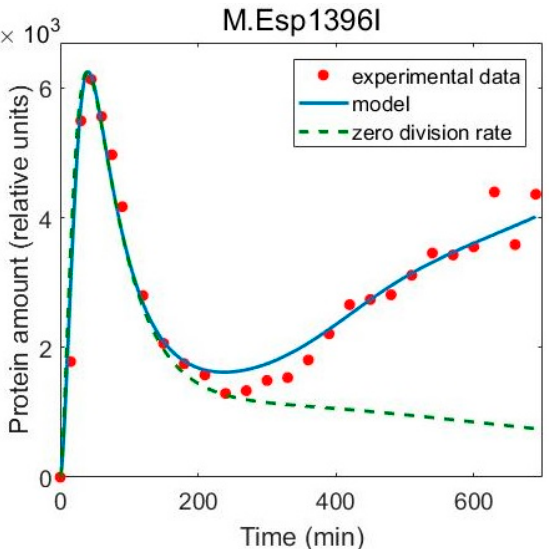
Figure 6. Effect of plasmid dynamics on intracellular M amounts. Experimentally measured intracellular M.Esp1396I amounts at different time points after transformation are denoted by red dots. The solid blue curve is the full model prediction, while the dashed green curve is obtained by setting the plasmid division rate in the full model to zero.